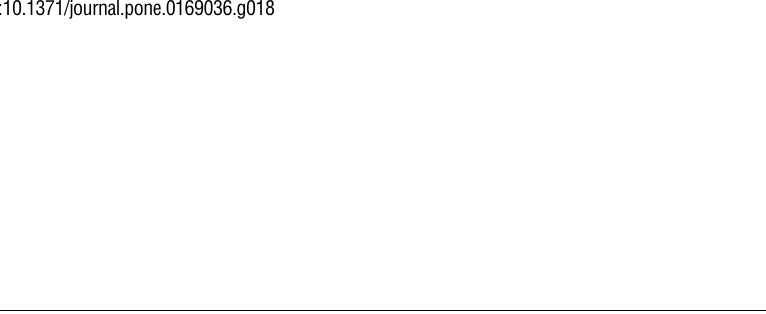
Fig 18. Infinity shape trajectoriesfrom NAG and camerapositioning